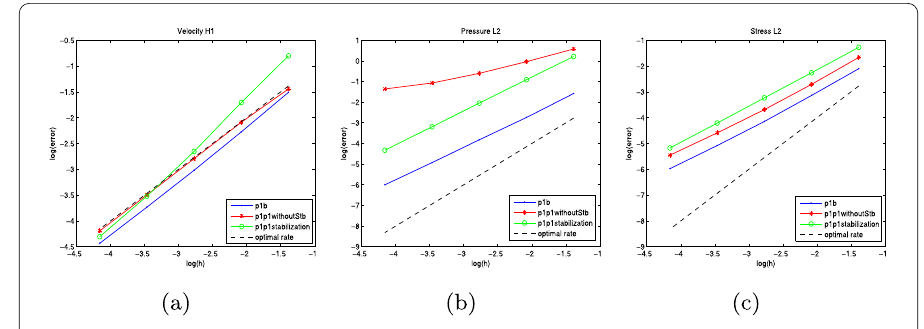
Figure 1 The illustration of the order of convergence. ( a ) H 1 -norm error for velocity; ( b ) L 2 -norm error for pressure; ( c ) L 2 -norm error for